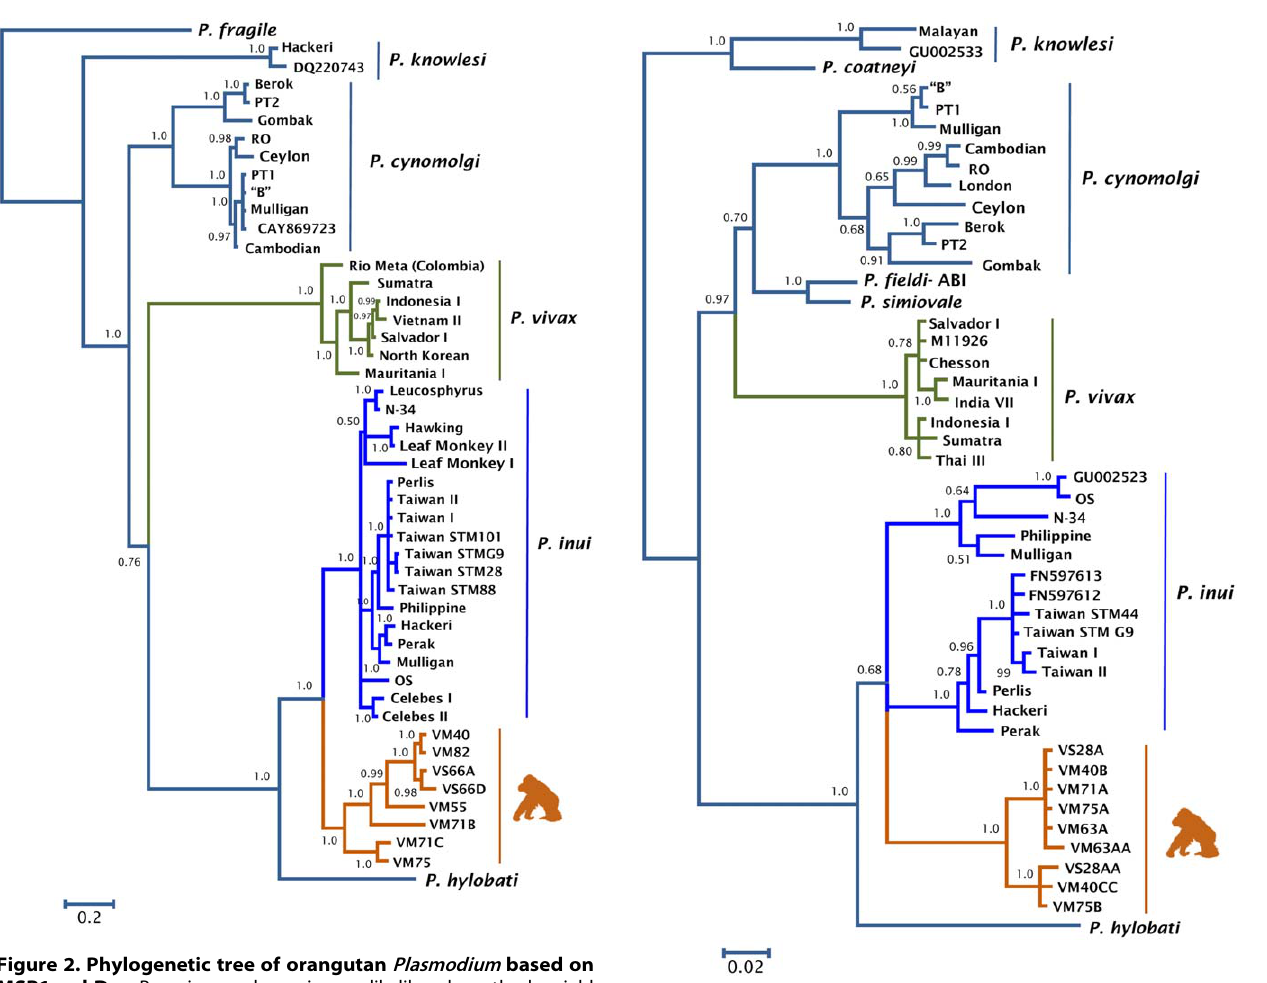
Figure 2. Phylogenetic tree of orangutan Plasmodium based on MSP1 42 kDa. Bayesian and maximum likelihood methods yield identical topologies so only the Bayesian tree is shown. The values above branches are posterior probabilities together with bootstrap values (in bold) as a percentage obtained for the maximum likelihood tree (see methods).